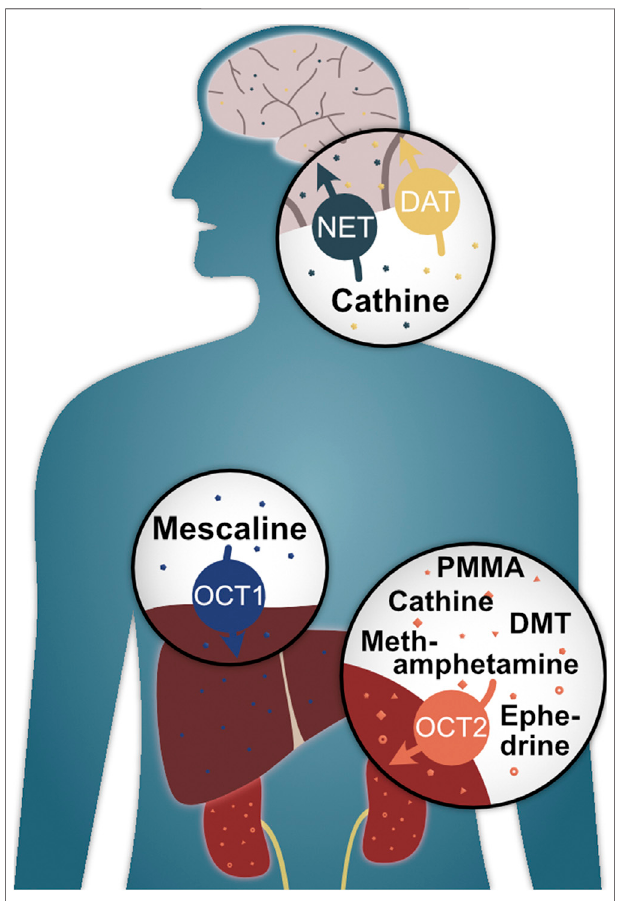
FIGURE 8 | Illustrated summary of key fi ndings of this study and their potential biological relevance.